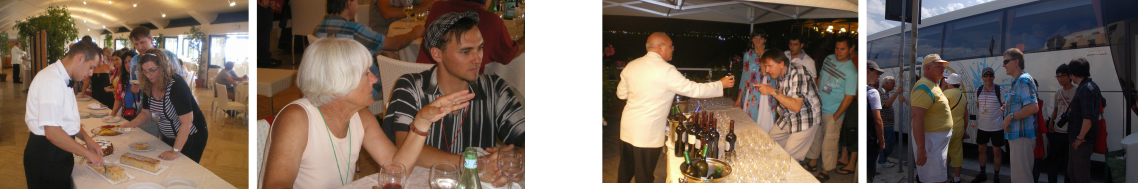
Figure 12: The Etruscan wine tasting and departure for the conference trip.